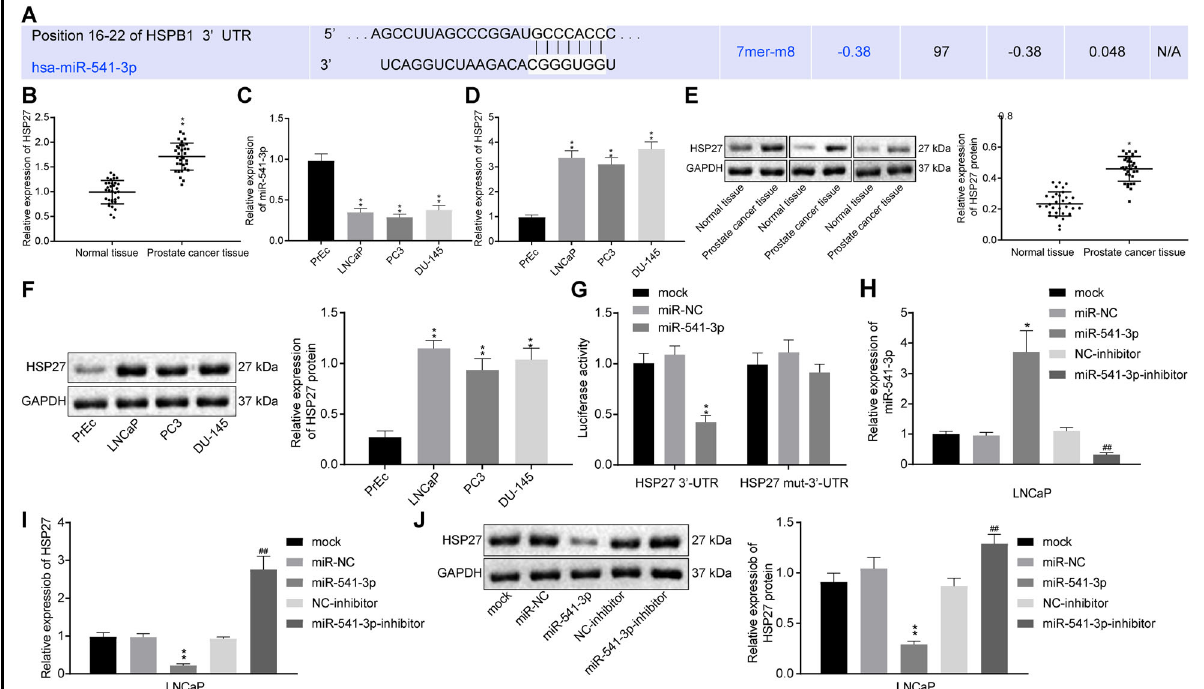
Fig. 3 miR-541-3p targets and negatively regulates HSP27 expression. A Binding site of miR-541-3p and HSP27 in 3 ′ -UTR predicted by TargetScan. B The mRNA expression of HSP27 in PCa tissues and adjacent noncancerous tissues determined by RT-qPCR, ** p < 0.01 relative to normal tissues ( n = 33). C Expression of miR-541-3p in human PCa cell lines (LNCaP, PC3, du-145) and prostatic epithelial cells PrEc determined by RT-qPCR. D Expression of HSP27 in human PCa cell lines (LNCaP, PC3, du-145) and prostatic epithelial cells PrEc determined by RT-qPCR. E HSP27 protein expression in PCa tissues and adjacent noncancerous tissues measured by western blot assay, ** p < 0.01 compared with normal tissues ( n = 33). F HSP27 protein expression in human PCa cell lines (LNCaP, PC3, DU-145) and PrEc cells measured by western blot assay, ** p < 0.01 relative to PrEc cells. G Luciferase activity in LNCaP cells 48 h after co-transfection with WT HSP27 or Mut HSP27 vector and miR-541-3p or NC. Values were expressed as mean ± SEM, compared with the control group, ** p < 0.01. H After LNCaP cells were transfected with miR-541-3p, the expression of miR-541-3p was detected by RT-qPCR, compared with the control group, ** p < 0.01. I After LNCaP cells were transfected with miR-541-3p, the mRNA level of HSP27 was determined by RT-qPCR, compared with the control group, ** p < 0.01. J After LNCaP cells were transfected with miR-541-3p, HSP27 protein level were measured by western blot assay, compared with the control group, ** p < 0.01. Paired t -test was used for comparison between the two groups and one-way analysis of variance was used for comparison between multiple groups. The values were expressed as mean ± SEM and the cell experiment was repeated for three